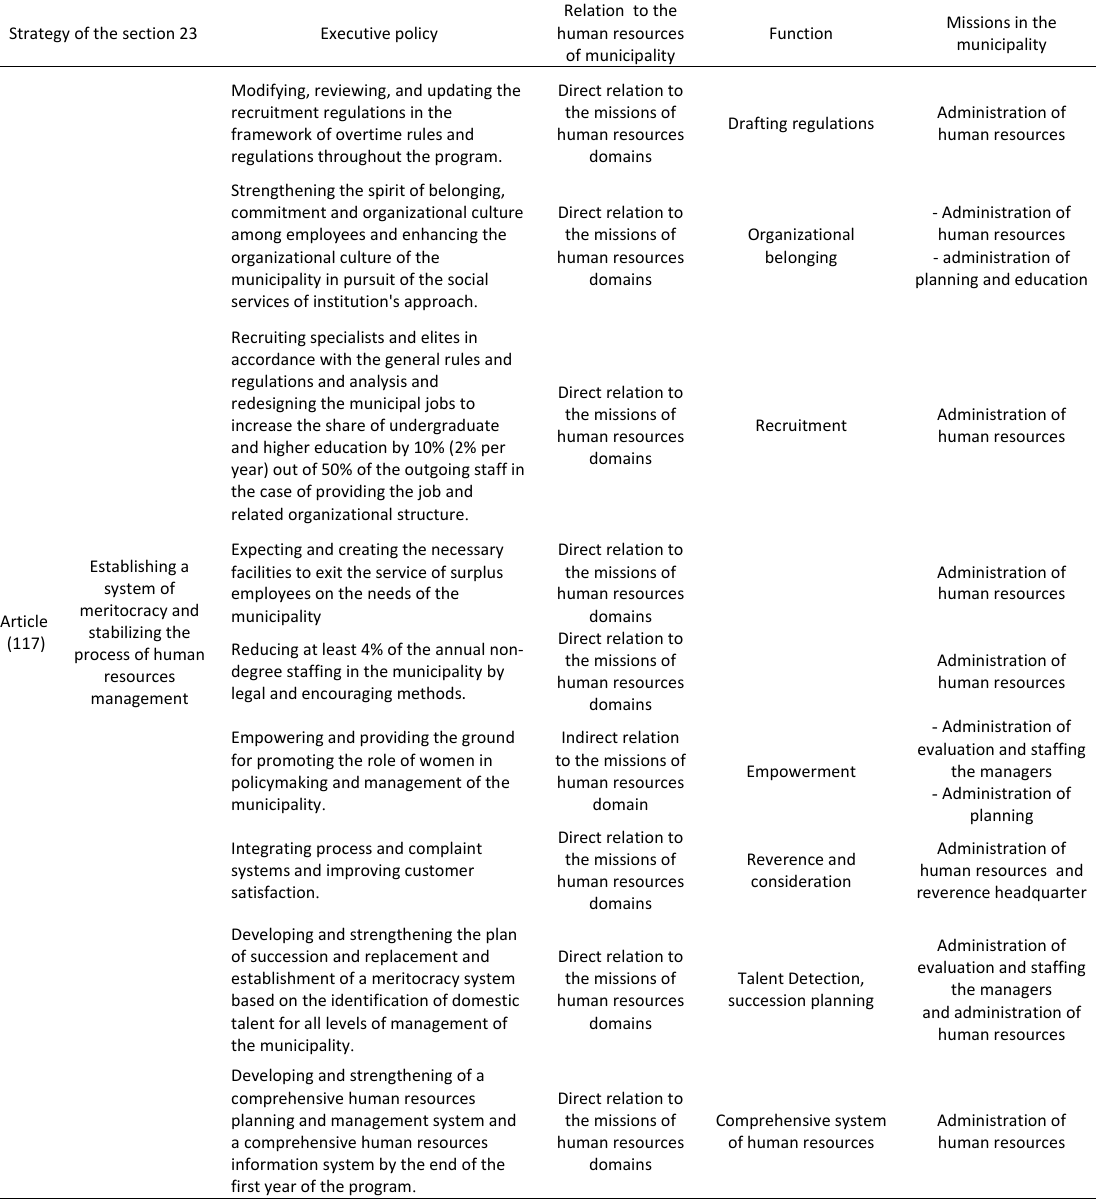
Table 4. Establishing meritocracy and a stable human resources management process cycle